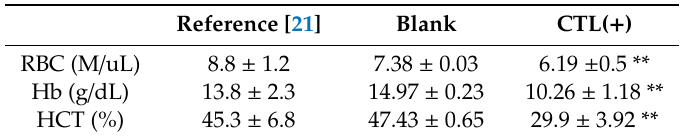
Table 5. Hematology values in the 21 day iron depletion experiment in